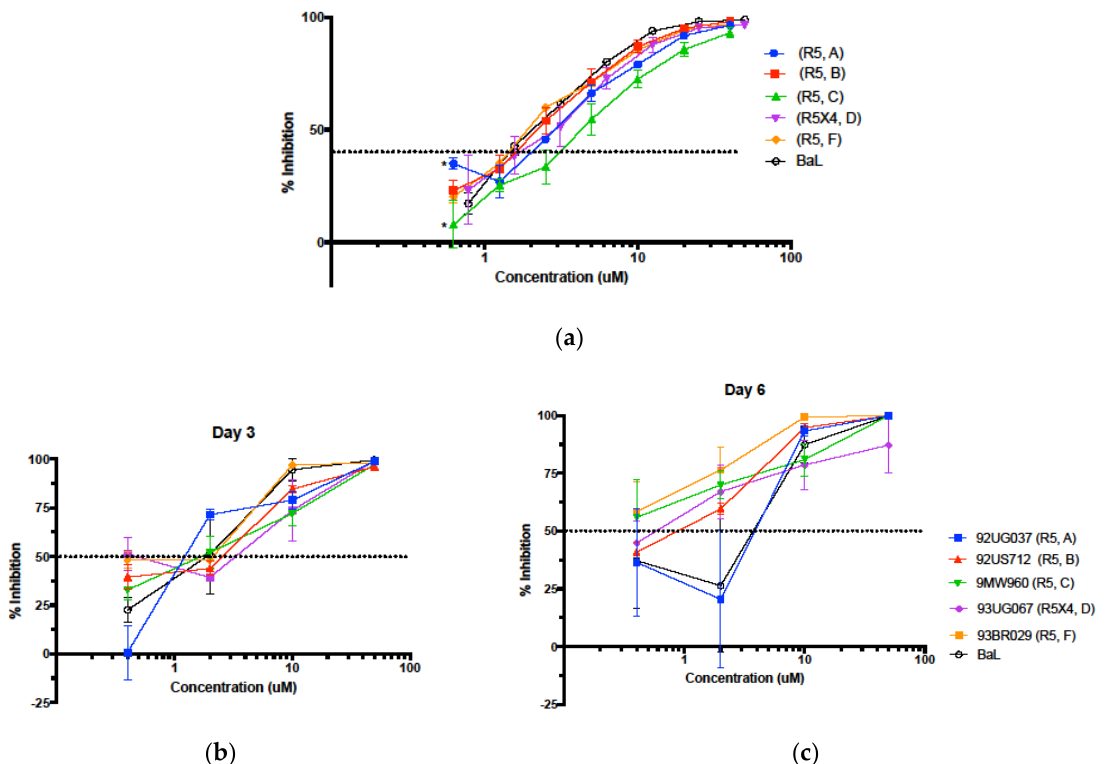
Figure 4. Avirulins are active against several HIV-1 clades and viral tropisms. Av-5 was used to inhibit HIV-1 clinical isolates from a wide range of clades using a TZM-bl luciferase reporter assay. Clinical isolates were obtained from the NIH AIDS Reagent Program and grown in PM1 cells, then viral supernatants were used to infect TZM-bl for 24 h ( a ). Percent inhibition was calculated by comparison to DMSO vehicle control (a). n = 3, error = SEM, inhibition against each clade was compared to HIV-1 BaL control, * = p < 0.05. PM1 cells were treated with Av-5 or DMSO, incubated for 1.5 h with clinical HIV-1 isolates, then PM1s were cultured for six days in the presence of Av-5 or DMSO, with retreatment on day three ( b , c ). Percent inhibition was determined by comparison of ng p24 / million cells, detected by